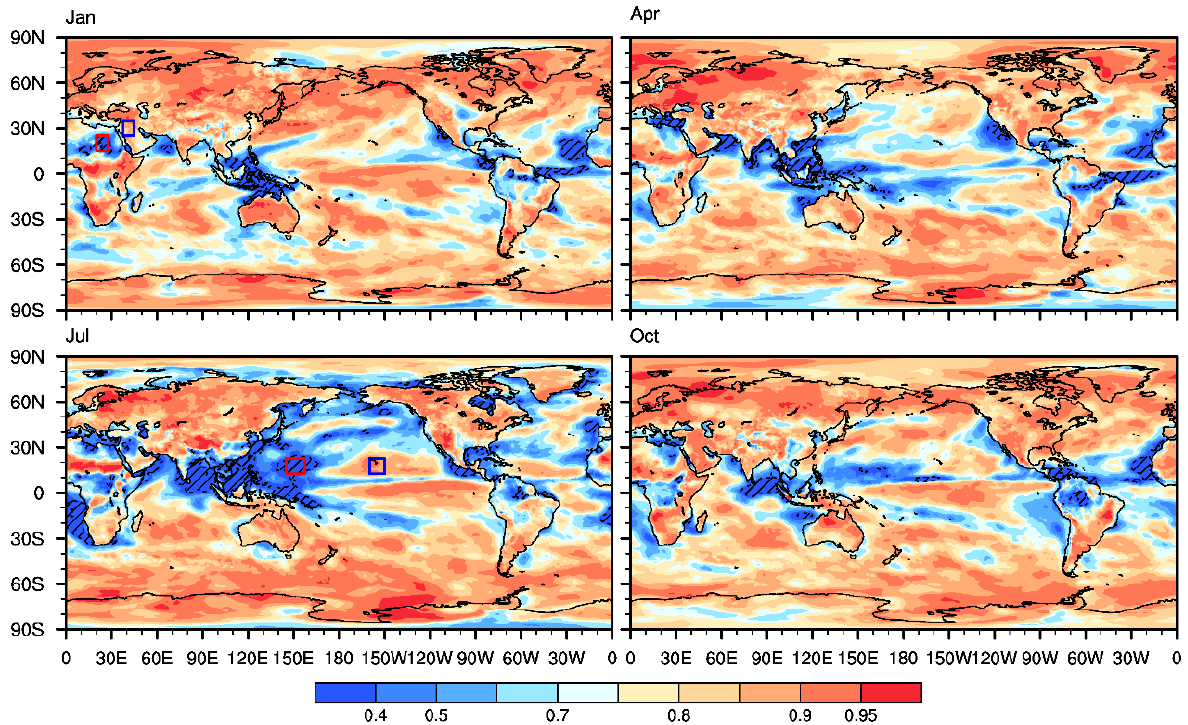
Figure 1. Maps of correlation coefficients of PW and SVP (the dataset used is ERA5). The correlation coefficients in shaded areas cannot pass the 0.05 significance level. Blue and red squares are strong and weak correlation areas, respectively, selected to show the vertical profiles.